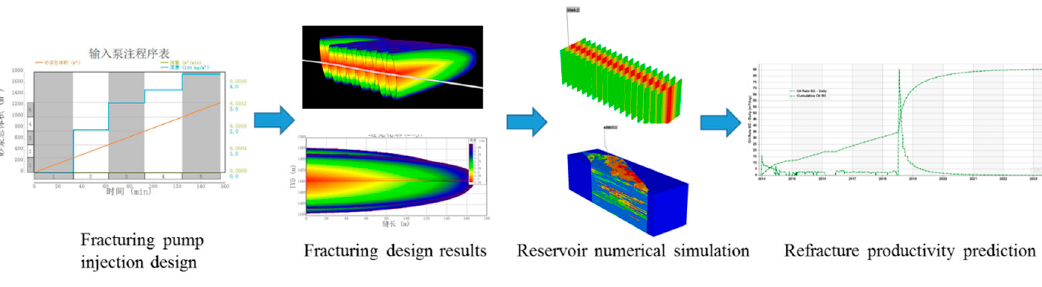
Figure 2. Workflow for predicting refracturing oil increase.